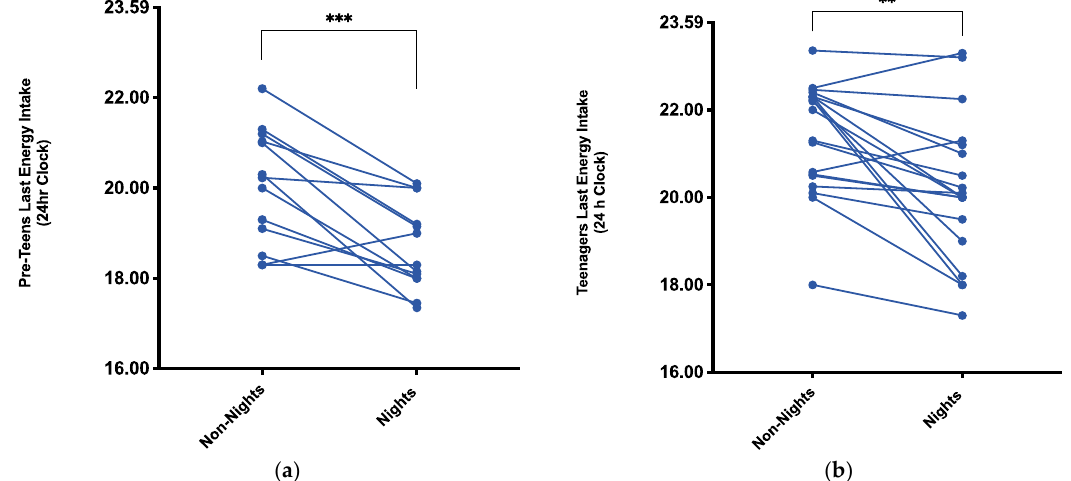
Figure 2. ( a ) Last recorded time of energy intake in the pre-teen group ( n = 13) and ( b ) the teen group children ( n = 19) in